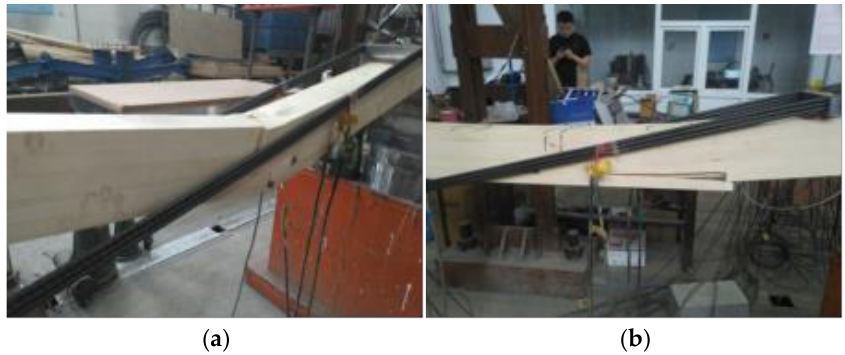
Figure 16. Failure mode of L A3 . ( a ) Tensile failure of left span; ( b ) Tensile failure of right span.